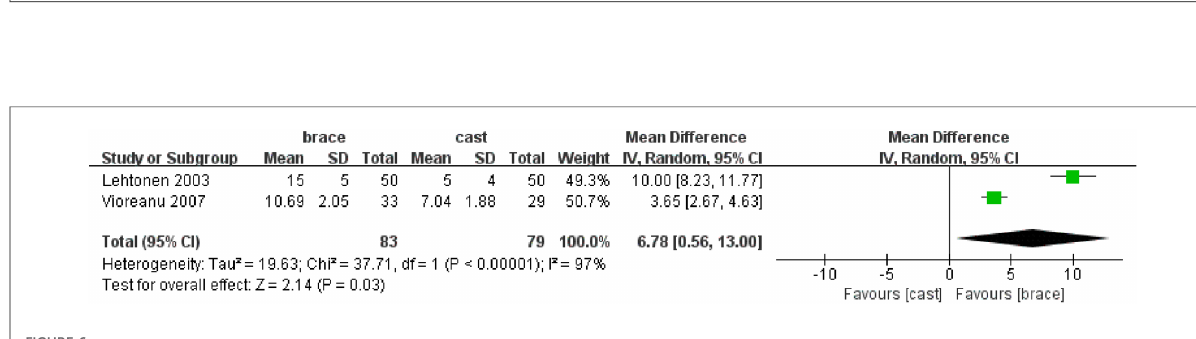
FIGURE 6 Forest plot of the comparison of cast versus brace groups for the ankle dorsi fl exion in 6w. CI, con fi dence interval.